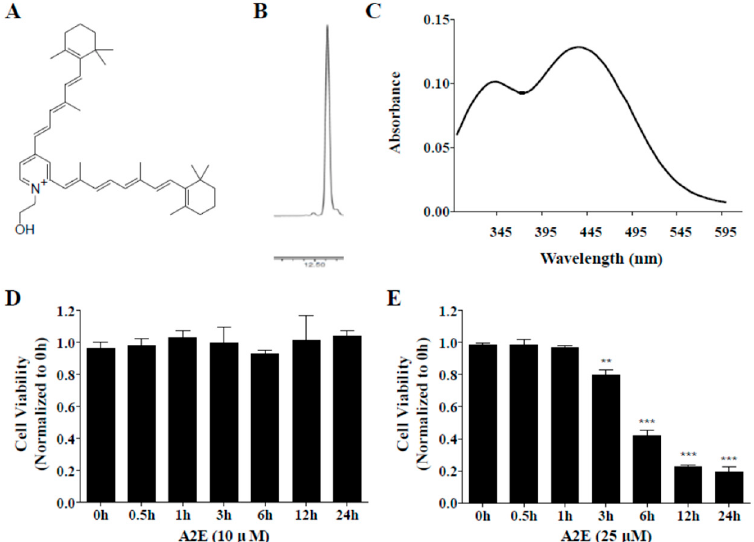
Figure 3. Characteristics of synthesized A2E. ( A ) Chemical structure of A2E. ( B ) Chromatogram of HPLC-purified A2E by HPLC. ( C ) UV spectra and structure of synthesized A2E. ( D , E ) Optimization